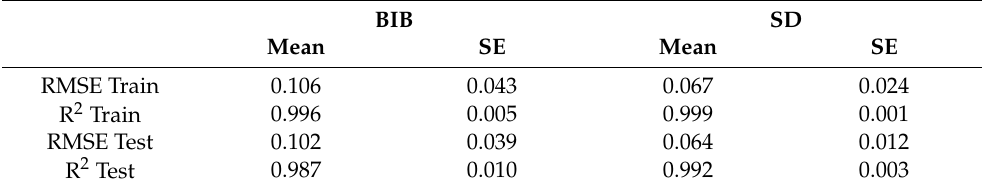
Table 3. Performance statistics for the Partial Least Square (PLS) based acceptability model for both training and test datasets—R 2 and Root Mean Squared Error (RMSE). BIB SD